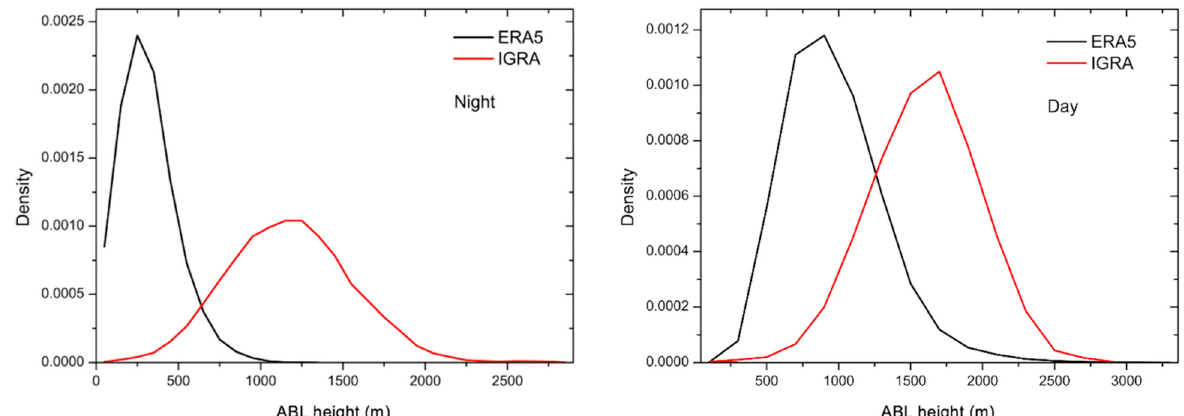
Figure 3. Density functions of the BLH monthly averages for the night ( left panel) and day ( right panel) time data of ERA5 (black lines) and Integrated Global Radiosounding Archive (IGRA, red lines). Different vertical scales are used to permit the integral plotting of the pair of density functions.